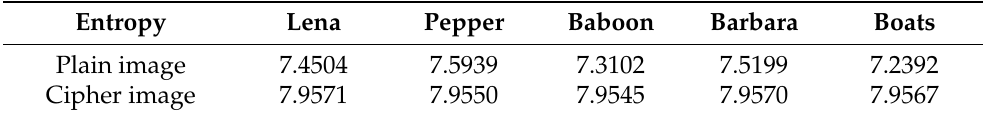
Table 8. Entropy results